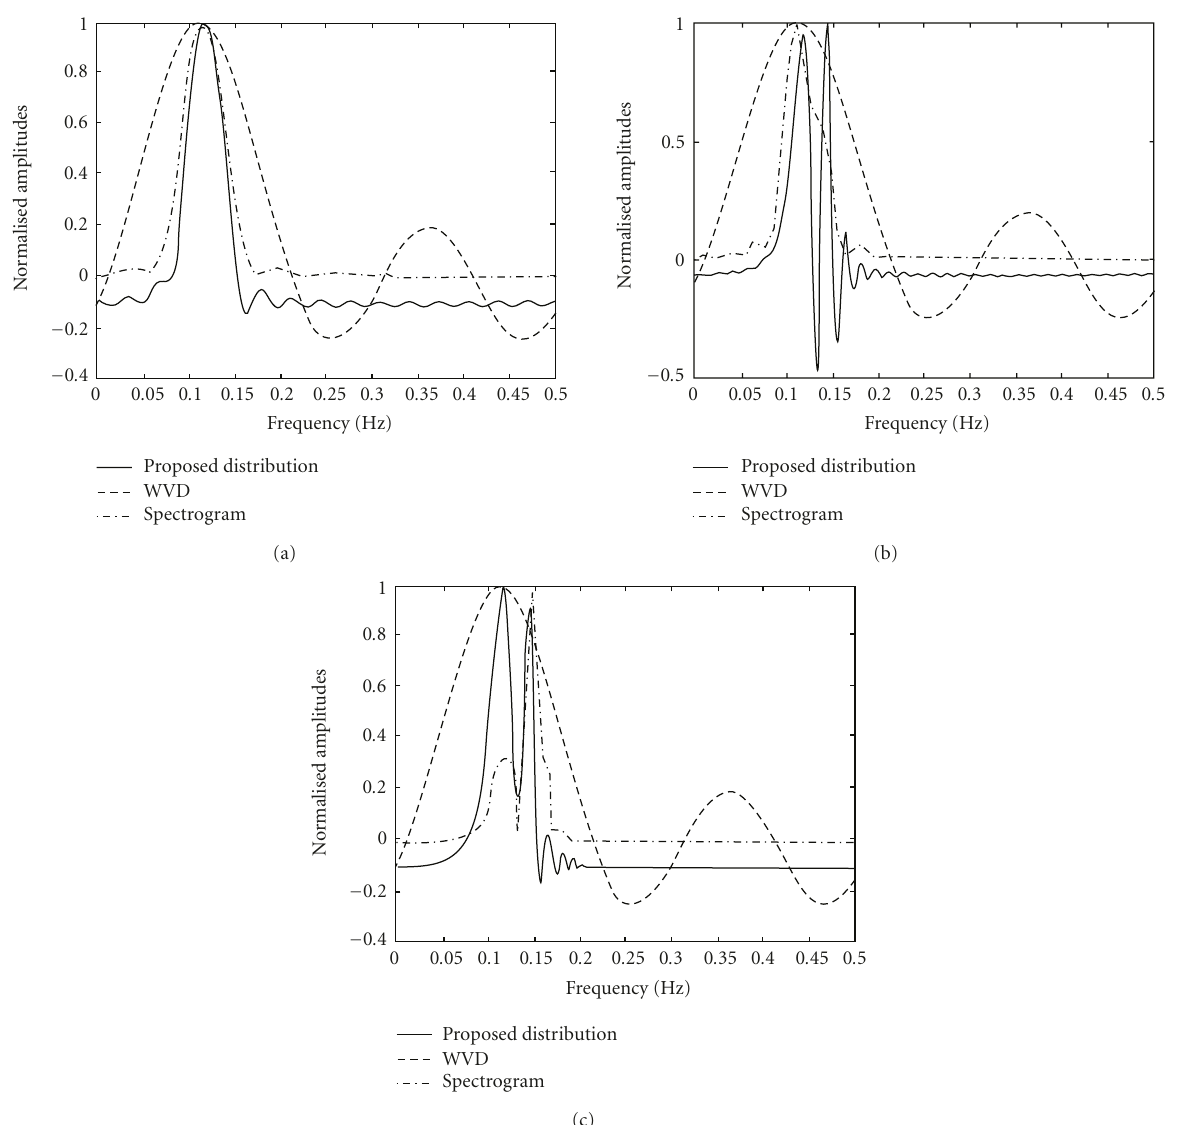
Figure 12: Slices taken at the same time instant n = 3 (signal start time instant) of the WD, the spectrogram, and the proposed TFD for a multicomponent signal composed of two parallel linear FM components using (a) a small size window length, (b) a medium size window length, and (c) a large size window length (adopted from Barkat and Boashash